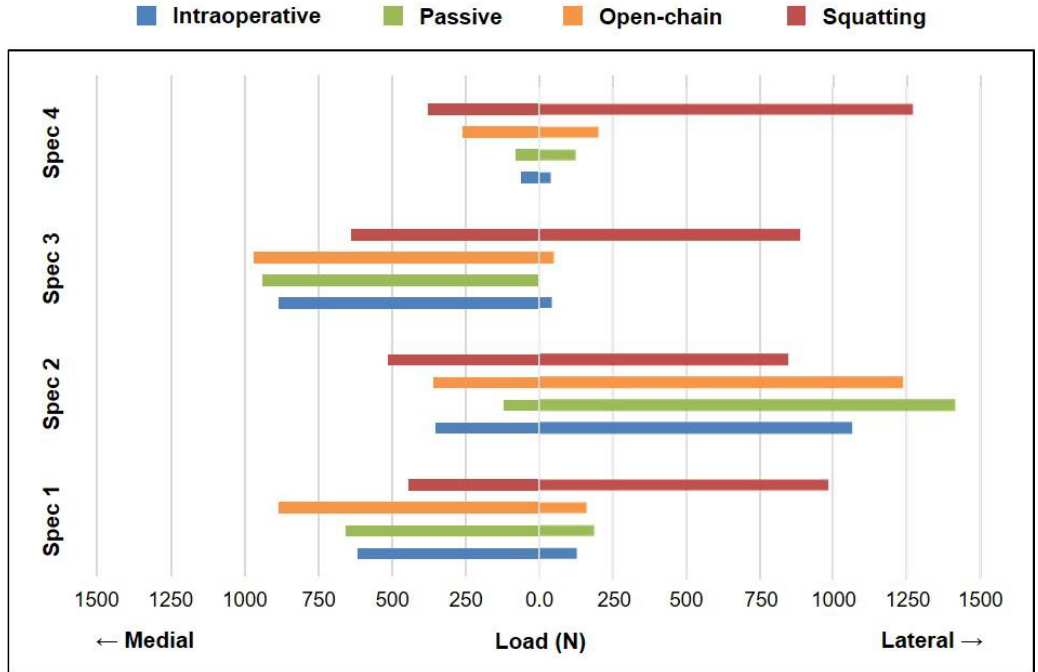
Figure 4. Peak total intra-articular load distribution in the medial (left) and lateral (right) compartments across the range of knee flexion for each specimen measured intraoperatively (blue) and during passive flexion – extension (green), open-chain extension (orange), and active squatting (red). Peak load was observed in extension when measured intraoperatively (0°) and during passive flexion – extension (0°) and open-chain extension (10°), while peak load during squatting was observed in deep flexion (100°).